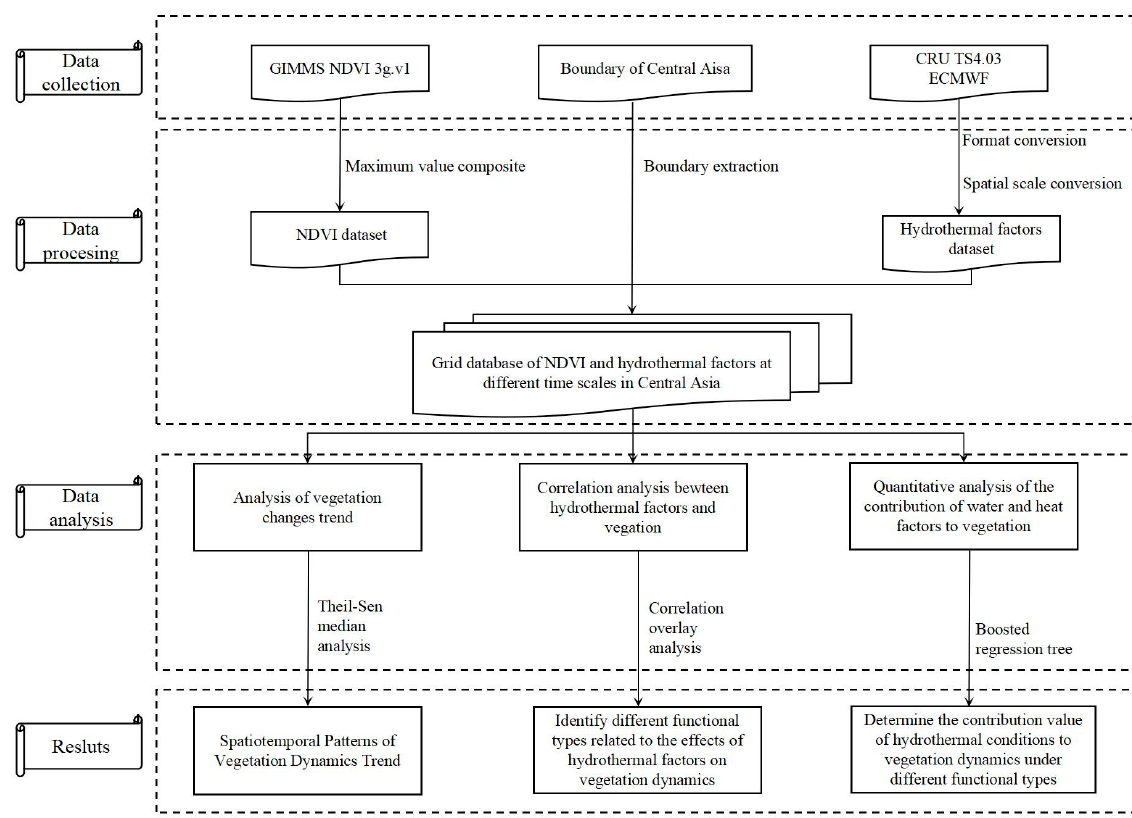
Figure A1. The flowchart of this study.